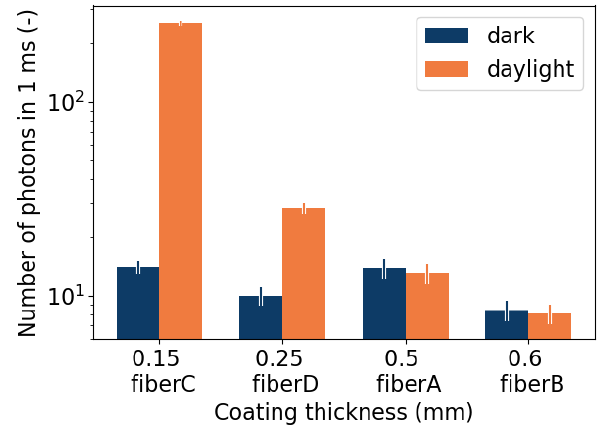
Fig. 7. Number of background light photons filtering from the optical fiber jacket in 1 ms as a function of the jacket thickness, in two different light conditions.